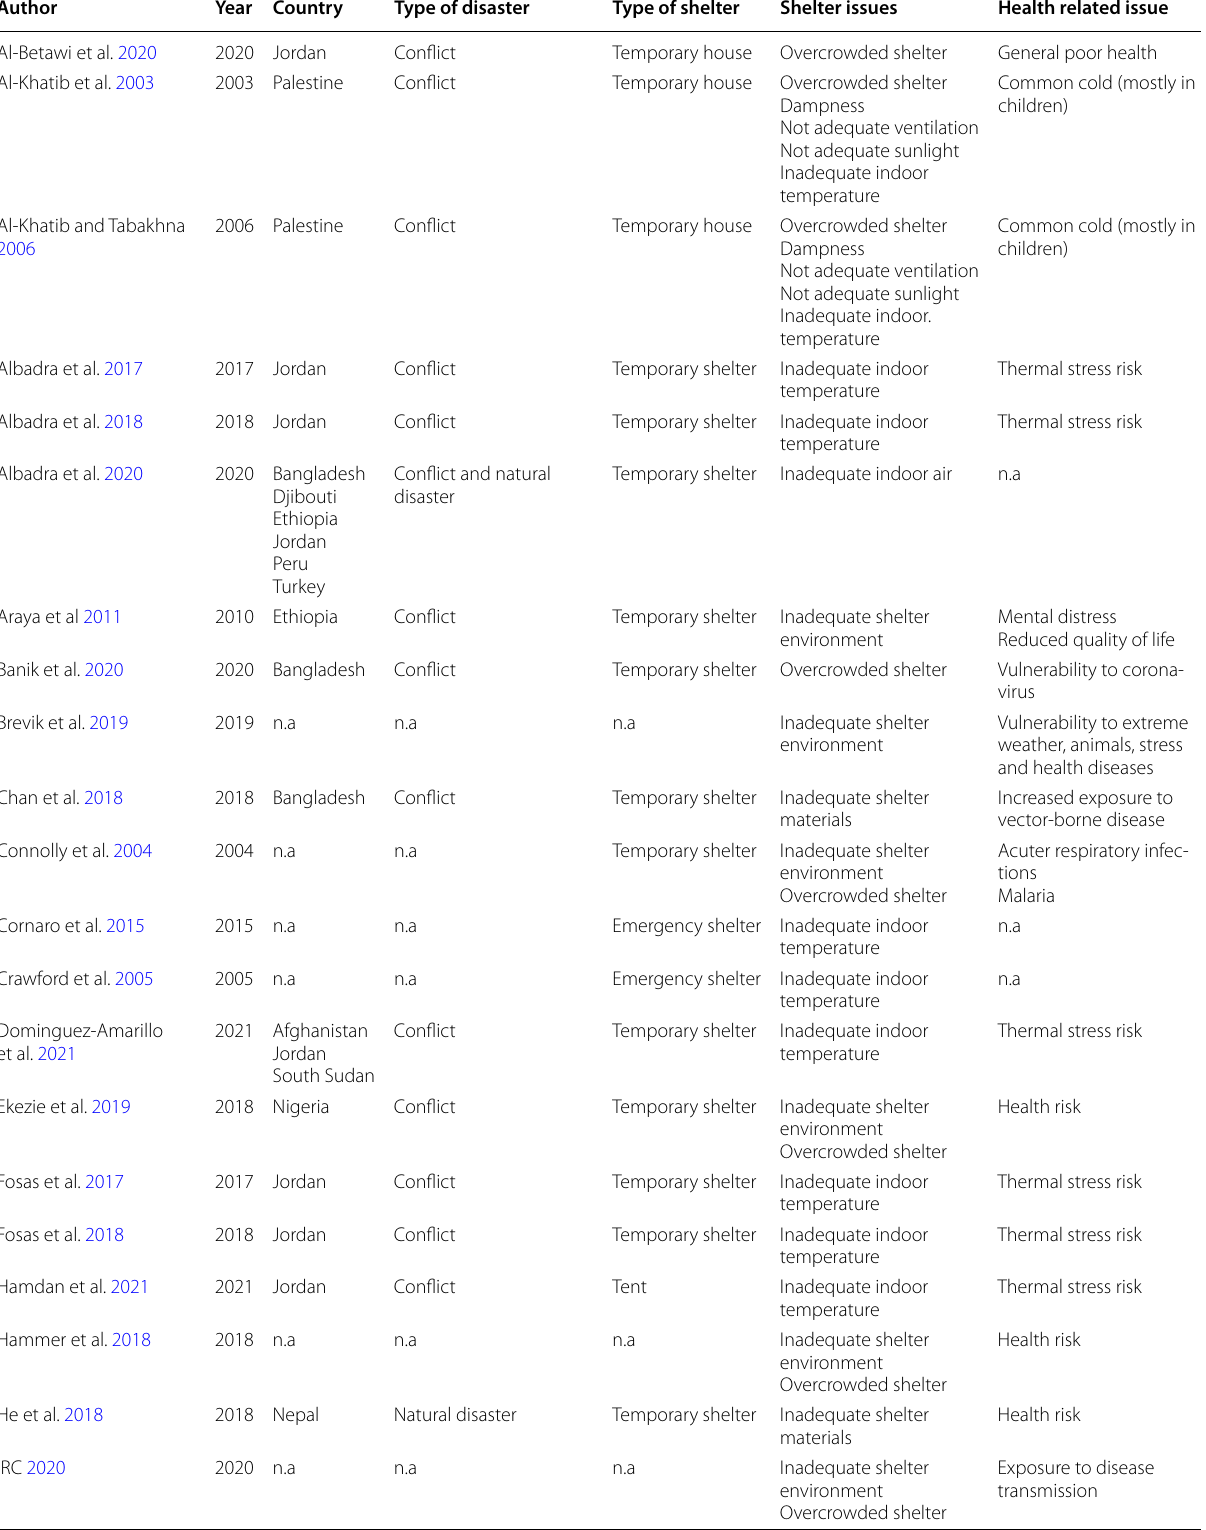
Table 1 Overview of the health diseases related to shelter issues in included journal papers (Literature reviews are not